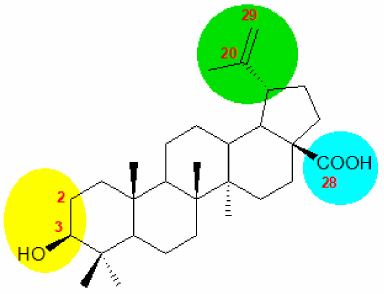
Figure 2. The structural formula of BA and C-2/C-3, C-20/C-29 and C-28 positions amenable to chemical